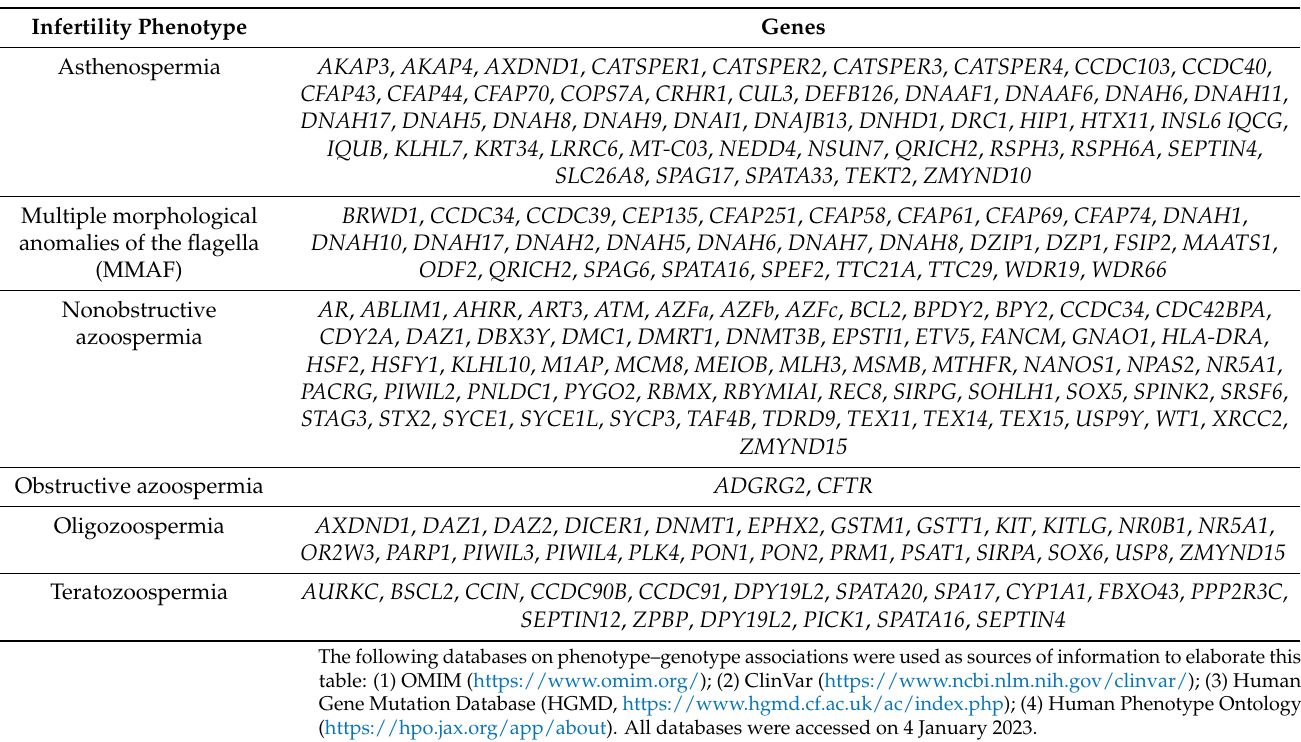
Table 1. Genes in which mutations or gene expression changes were identified with the respective infertility phenotype